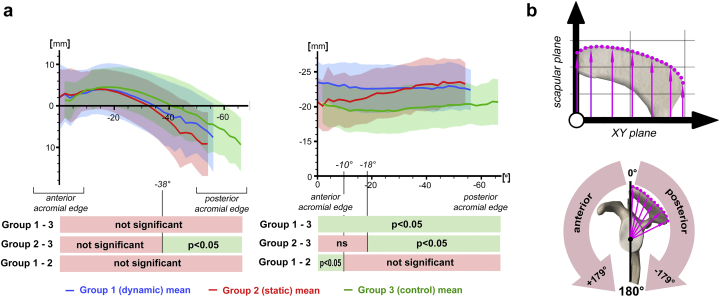
Lateral acromial coverage and lateral acromial height. (a) Table with visualized lateral acromial coverage and lateral acromial height. The mean curve per group is plotted from the mean angle of the anterior point of the acromial edge to the mean angle of the most posterior point of the acromial edge. Blue curve (mean values of group 1; dynamic instability) with blue bar (standard deviation). Red curve (mean values of group 2; static instability) with red bar (standard deviation). Green curve (mean values of group 3; control) with green bar (standard deviation). (b) Explanation of radial measurement of all lateral acromial points, whereby positive (+) values (from 0° to +180°) are anterior to the scapular plane and negative (−) values (from 0° to −180°) posterior. Example points (pink points) with corresponding measurement distances (pink arrows).